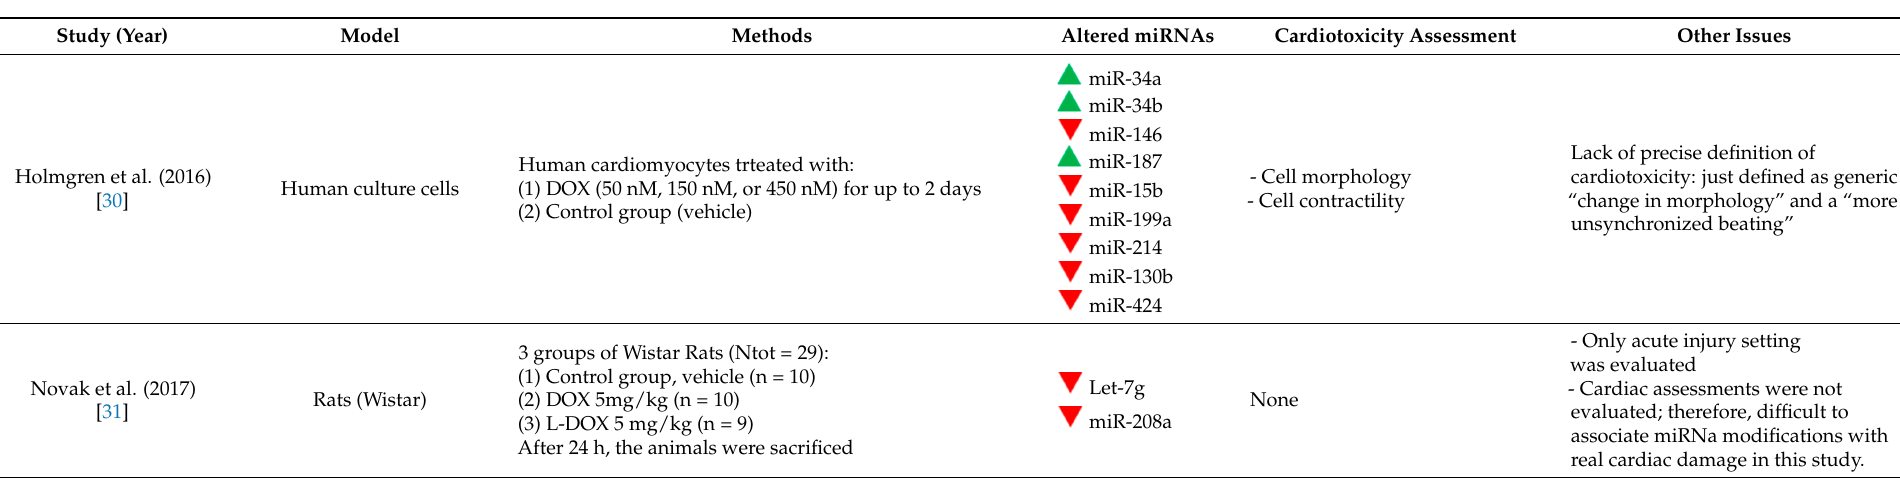
- Cell morphology - Cell contractility